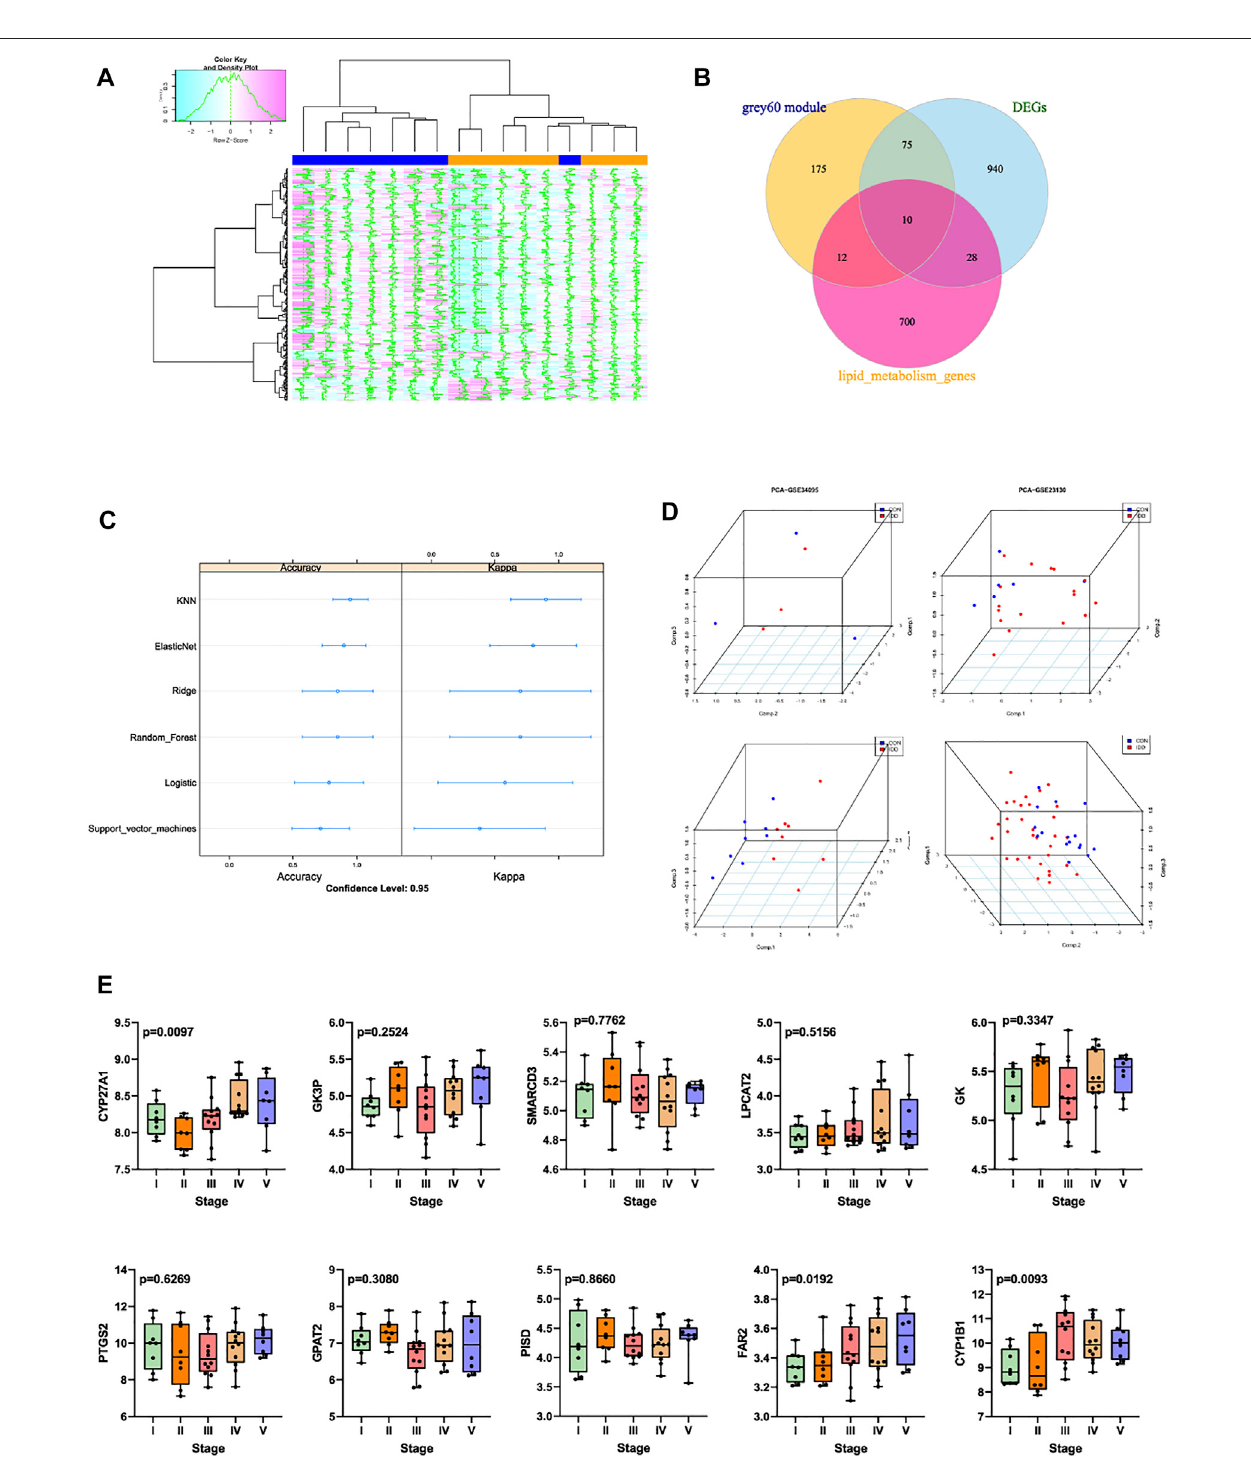
FIGURE 5 | (A) grey60 module genes expression heatmap among IDD and normal groups. (B) Venn diagram indicating 10 genes were commonly expressed in three parts. (C) summary dot plot of different machine learning models. (D) 3D scatter plot after PCA dimension reduction of these 10 genes in different datasets. (E) expression validation of these 10 genes in GSE70362.